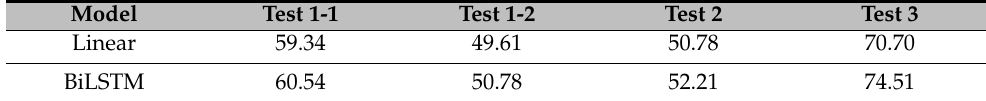
Table 4. Performance comparison of linear and BiLSTM models in